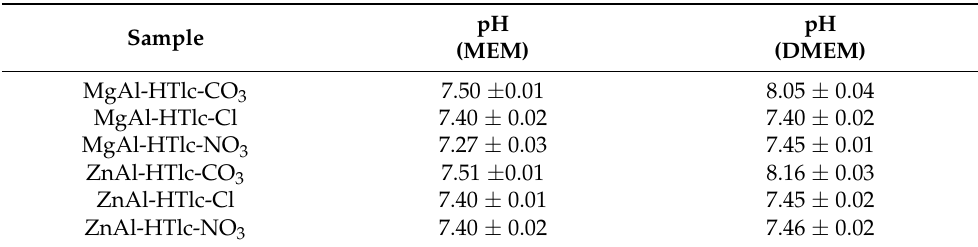
Table 3. pH values were measured for the supernatant obtained after incubation of HTlcs with culture media for 24 h at 37 ◦ C (n = 3; ± SD).